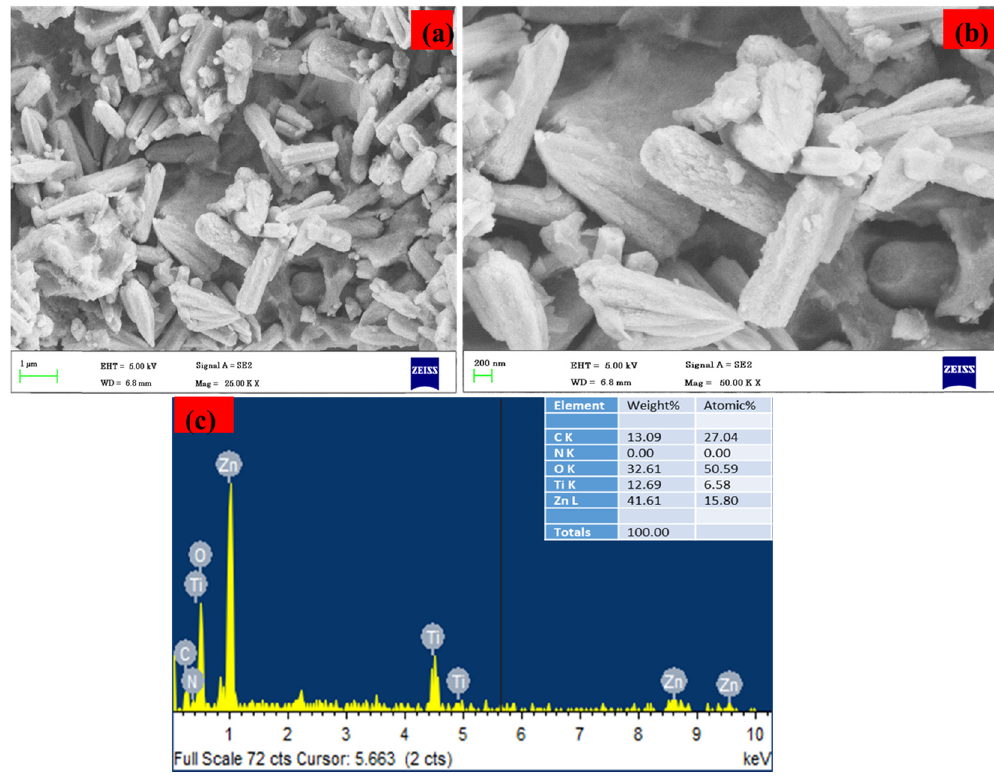
Figure 2: FESEM images of ZnO – TiO 2 – chitosan – escin bio - nanocomposites: ( a ) lower and ( b ) higher magni fi cations, and ( c ) EDAX